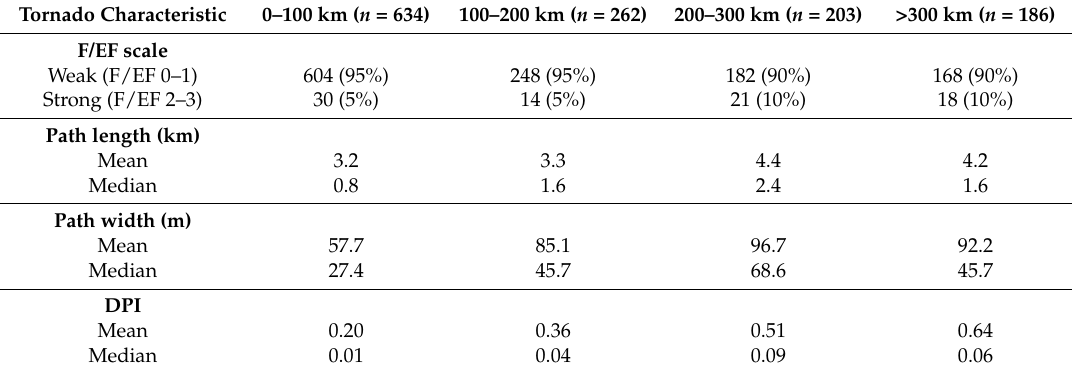
Table 3. Descriptive statistics for the 0–100 km, 100–200 km, 200–300 km, and >300 km regions. Tornado